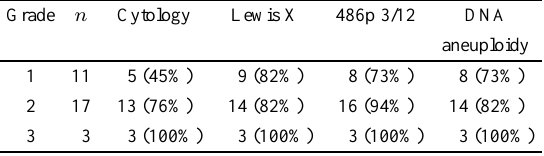
Detection rate of cytology, immunocytology and DNA-image- cytometry in different tumor grades of 31